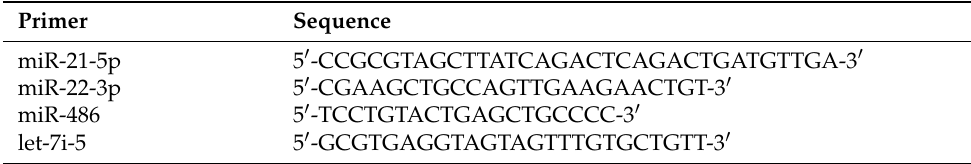
Table 1. Primer sequences for